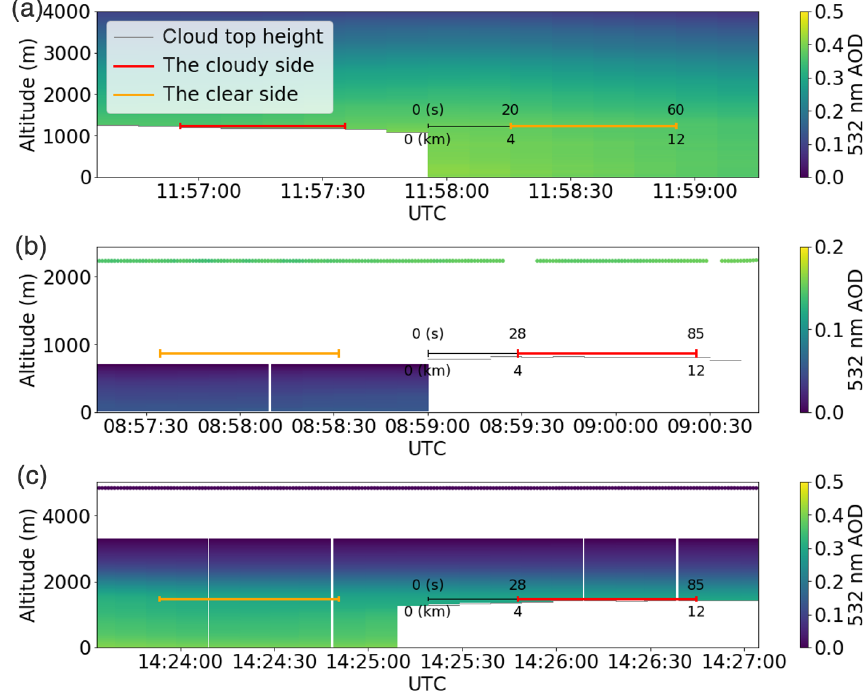
Figure 3. Examples of local-scale near-synchronous sampling, based on the HSRL-2 cloud top height (CTH) product. (a) In this subset of the ER2 flight on 12 September 2016, a cloud edge is found at 11:57:56 (denoted by 0s and 0km). The cloudy and clear sides, each with horizontal separation of 4–12km measured from cloud edge, are marked by red and orange lines, respectively. The HSRL-2 AOD profiles are given for altitudes from ∼ 50m above the clouds (as in Fig. 1a). (b) With the P3 500–1500m above the CTH (Fig. 1b), as is the case with this example from 5 October 2018, we use 4STAR AOD only. The 4STAR AOD is indicated at the P3 altitudes just above 2000m but refers to all altitudes above them. (c) With the P3 aircraft > 1500m above the CTH (Fig. 1c), as is the case for this example from 12 August 2017, the 4STAR AOD, indicated at the P3 altitudes just under 5000m, is added to the HSRL-2 AOD at ∼ 50m above the CTH. The upper limit of the integral of extinction is 1500m below the P3